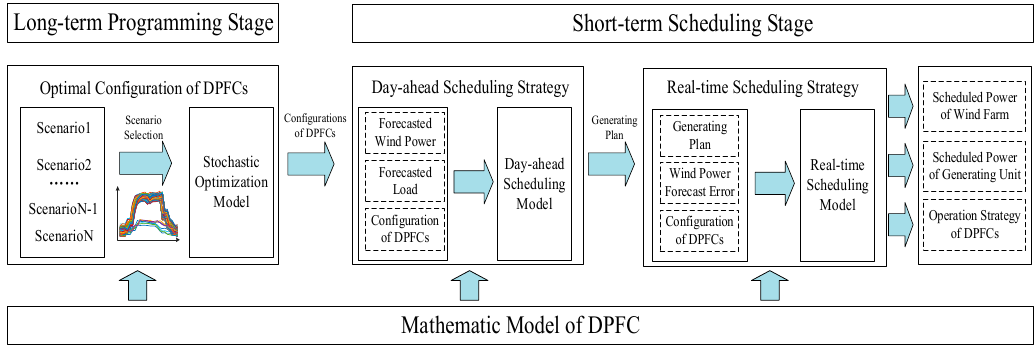
Figure 5. Framework of multi-time scale scheduling strategy with DPFCs.